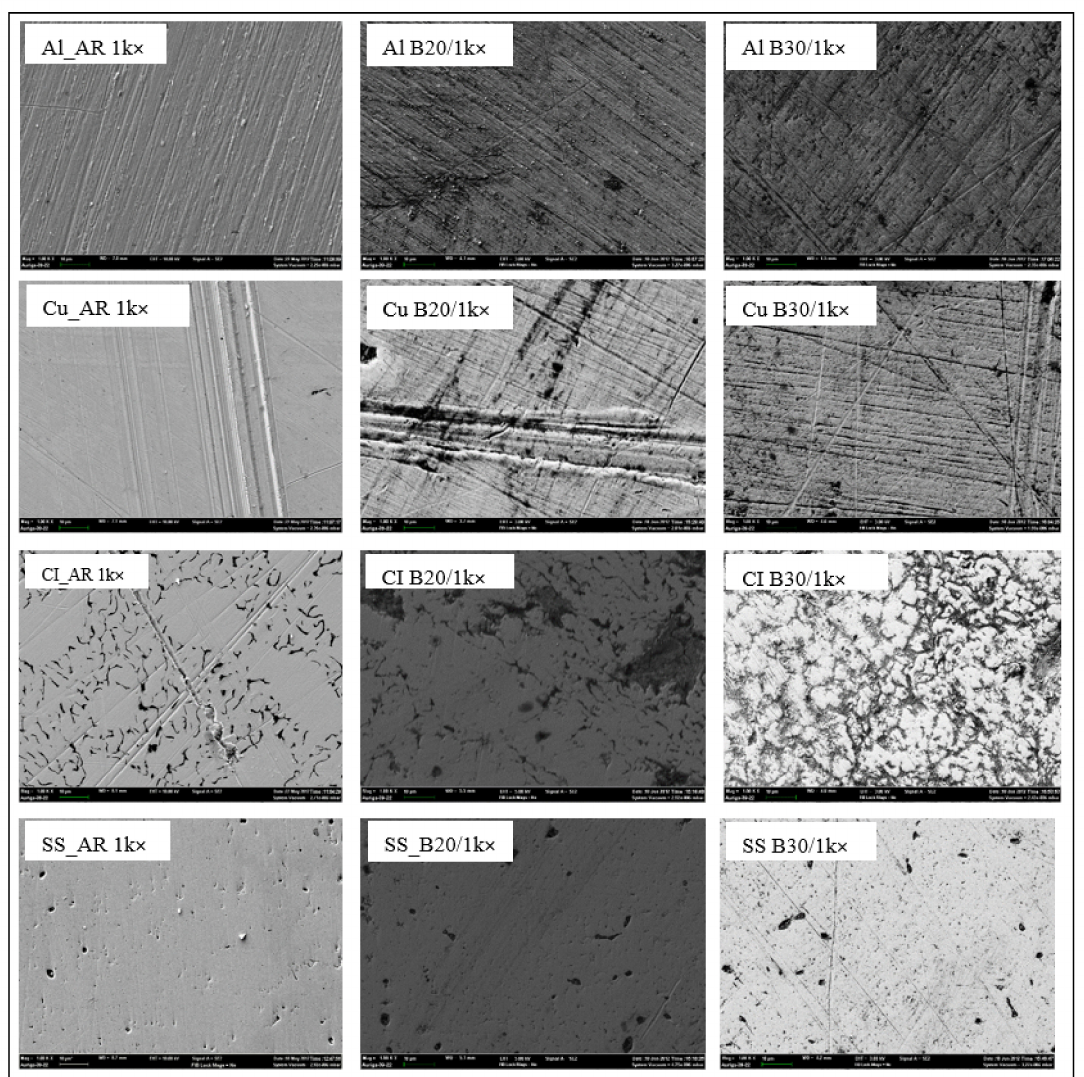
Figure 4. SEM microstructure of different materials immersed into biodiesel as received (AR) and post-immersion test